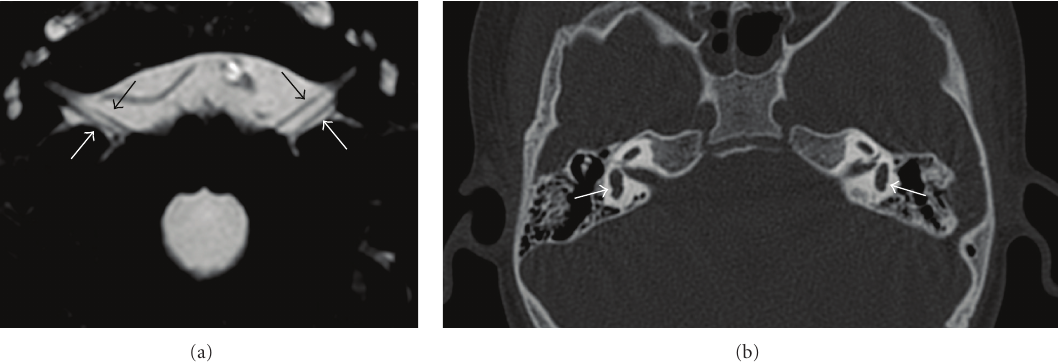
Figure 2: (a) Axial cross-sectional MRI 3D CISS sequence with mean intensity projection through the IAC and cerebellopontine angle. Only two nerves are detected: the facial nerve (black arrow) and the vestibular nerve (white arrow). (b) Axial CT image through the mastoid shows vestibules with dysplastic morphology (white arrow). Note the absence of semicircular canals.